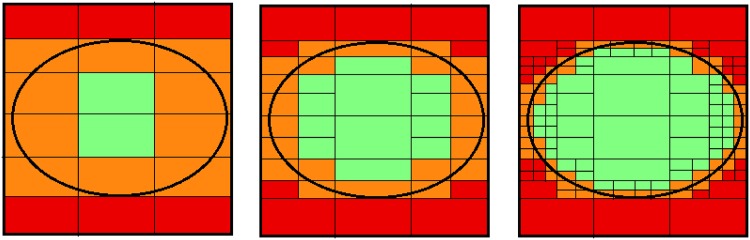
The three regions with evolving information.The sub-figures from left to right should be read as a, b and c respectively.